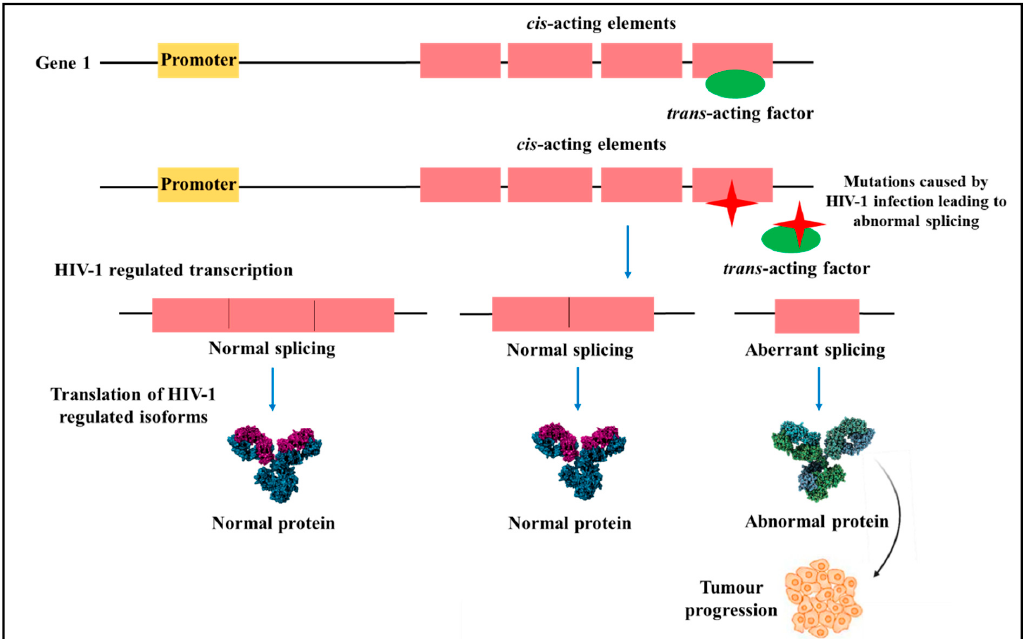
Figure 8. Mutations in cis -acting elements and trans -acting factors caused by Human immunodeficiency virus 1 (HIV-1). HIV-1 infections lead to deleterious mutations in cis -acting elements and trans -acting factors in prominent cellular genes leading to abnormal RNA splicing and abnormal protein translation [100].